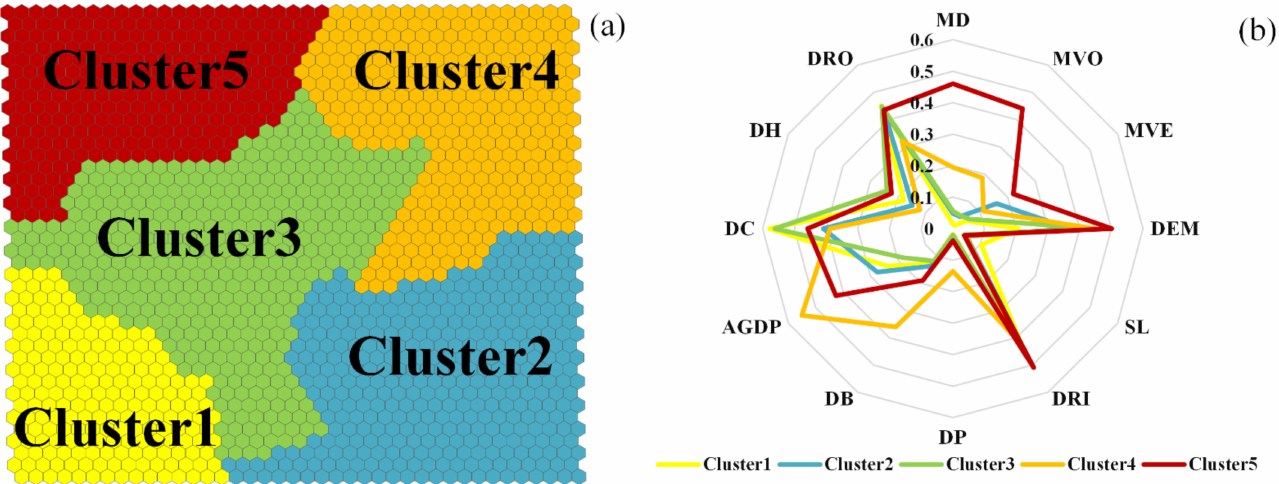
Figure 9. ( a ) SOM cluster distribution; ( b ) radar diagram of mean value of cluster indices (after